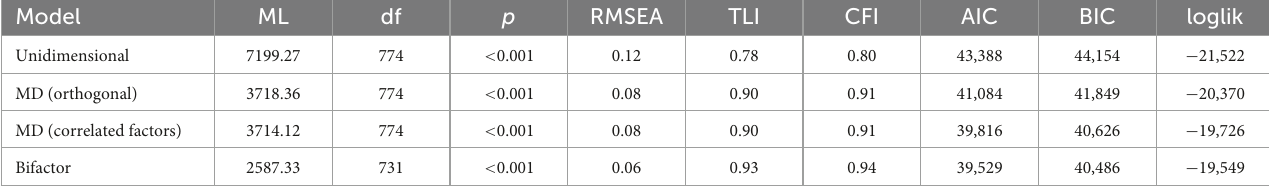
TABLE 2 Goodness-of fit-indices and information criteria from all competing models.